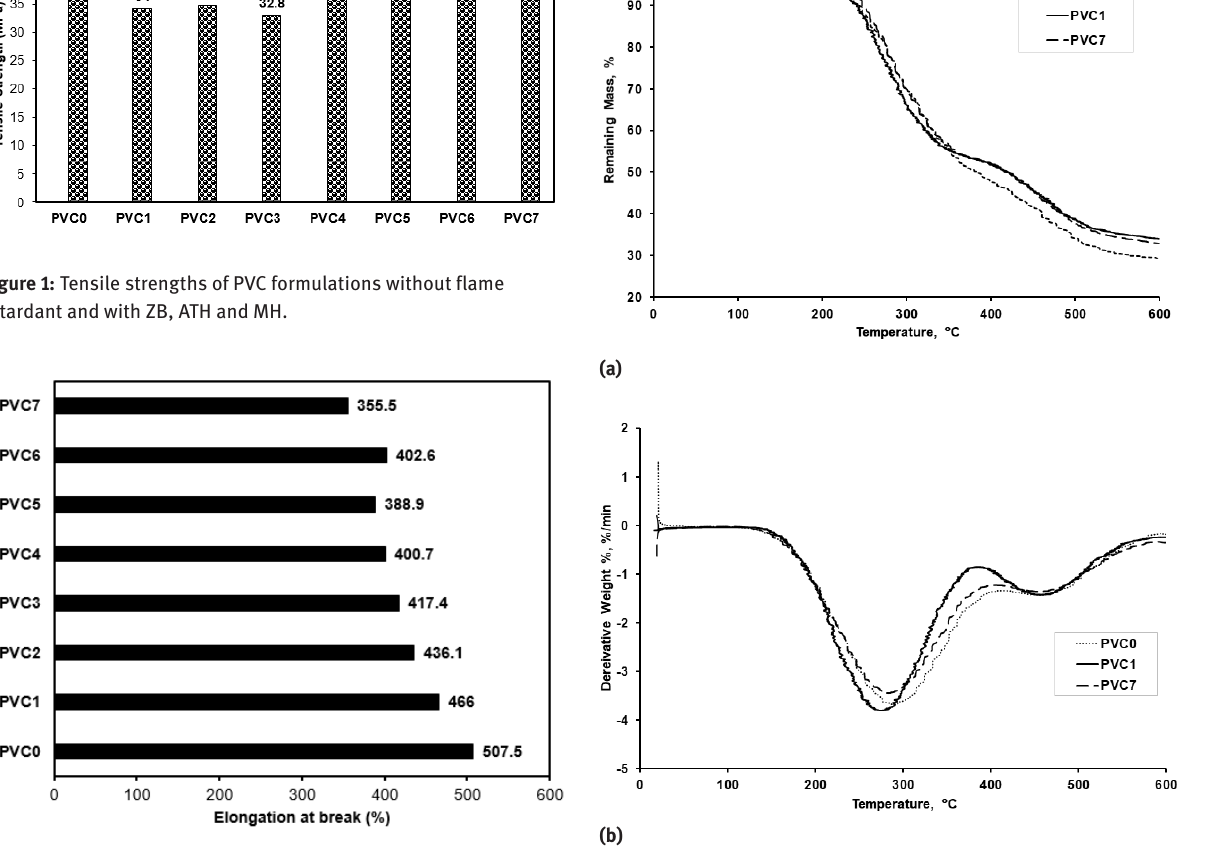
Figure 2: Elongation at break values of PVC composite samples.